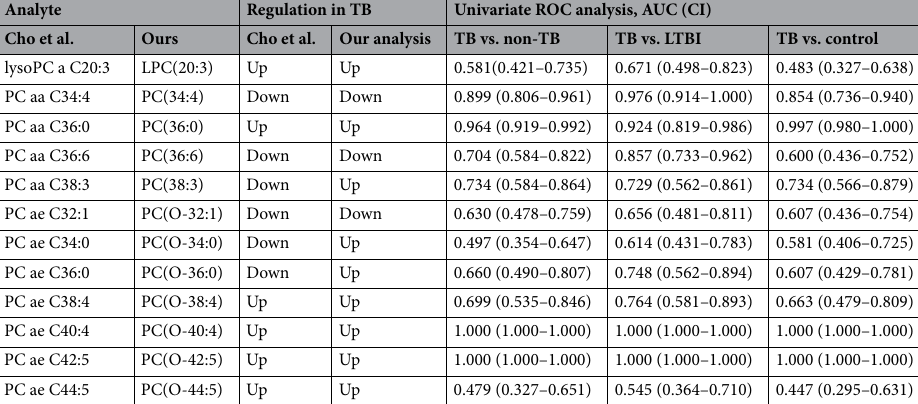
Table 2. External validation performance of 12 overlapping lipid biomarkers. TB tuberculosis, LTBI latent tuberculosis infection, AUC area under the curve, CI confidence interval, lysoPC